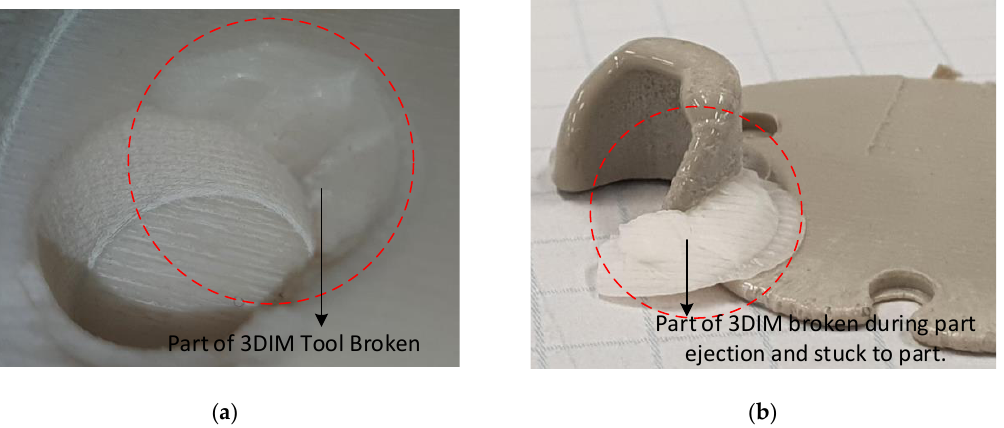
( b ) Figure 17. ( a ) Broken part with punched ejector holes stuck inside 3DIM cavity; ( b ) 3DIM cavity with broken part stuck inside after ejection and highlighting the potential expanded state of the